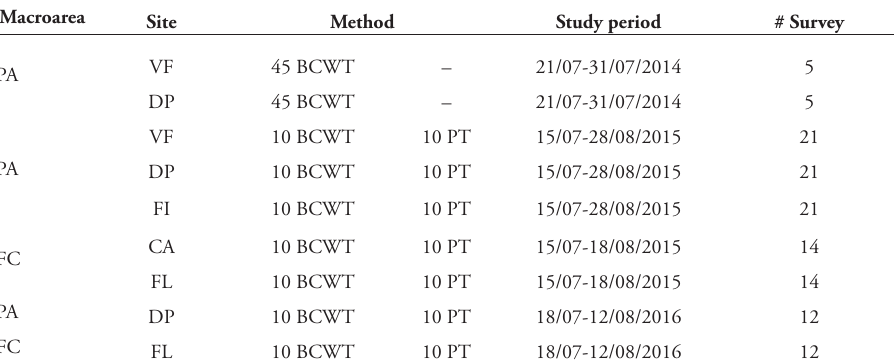
Table 1. Sampling design used during the MIPP project. Summary of the sampling design followed dur- ing the study of O. eremita in three years. (PA= Parco Nazionale d’Abruzzo Lazio e Molise; FC= Foreste Casentinesi; VF = Val Fondillo; DP = Difesa di Pescasseroli; FI= Feudo Intramonti e Colle di Licco; CA= Camaldoli; FL = Foresta della